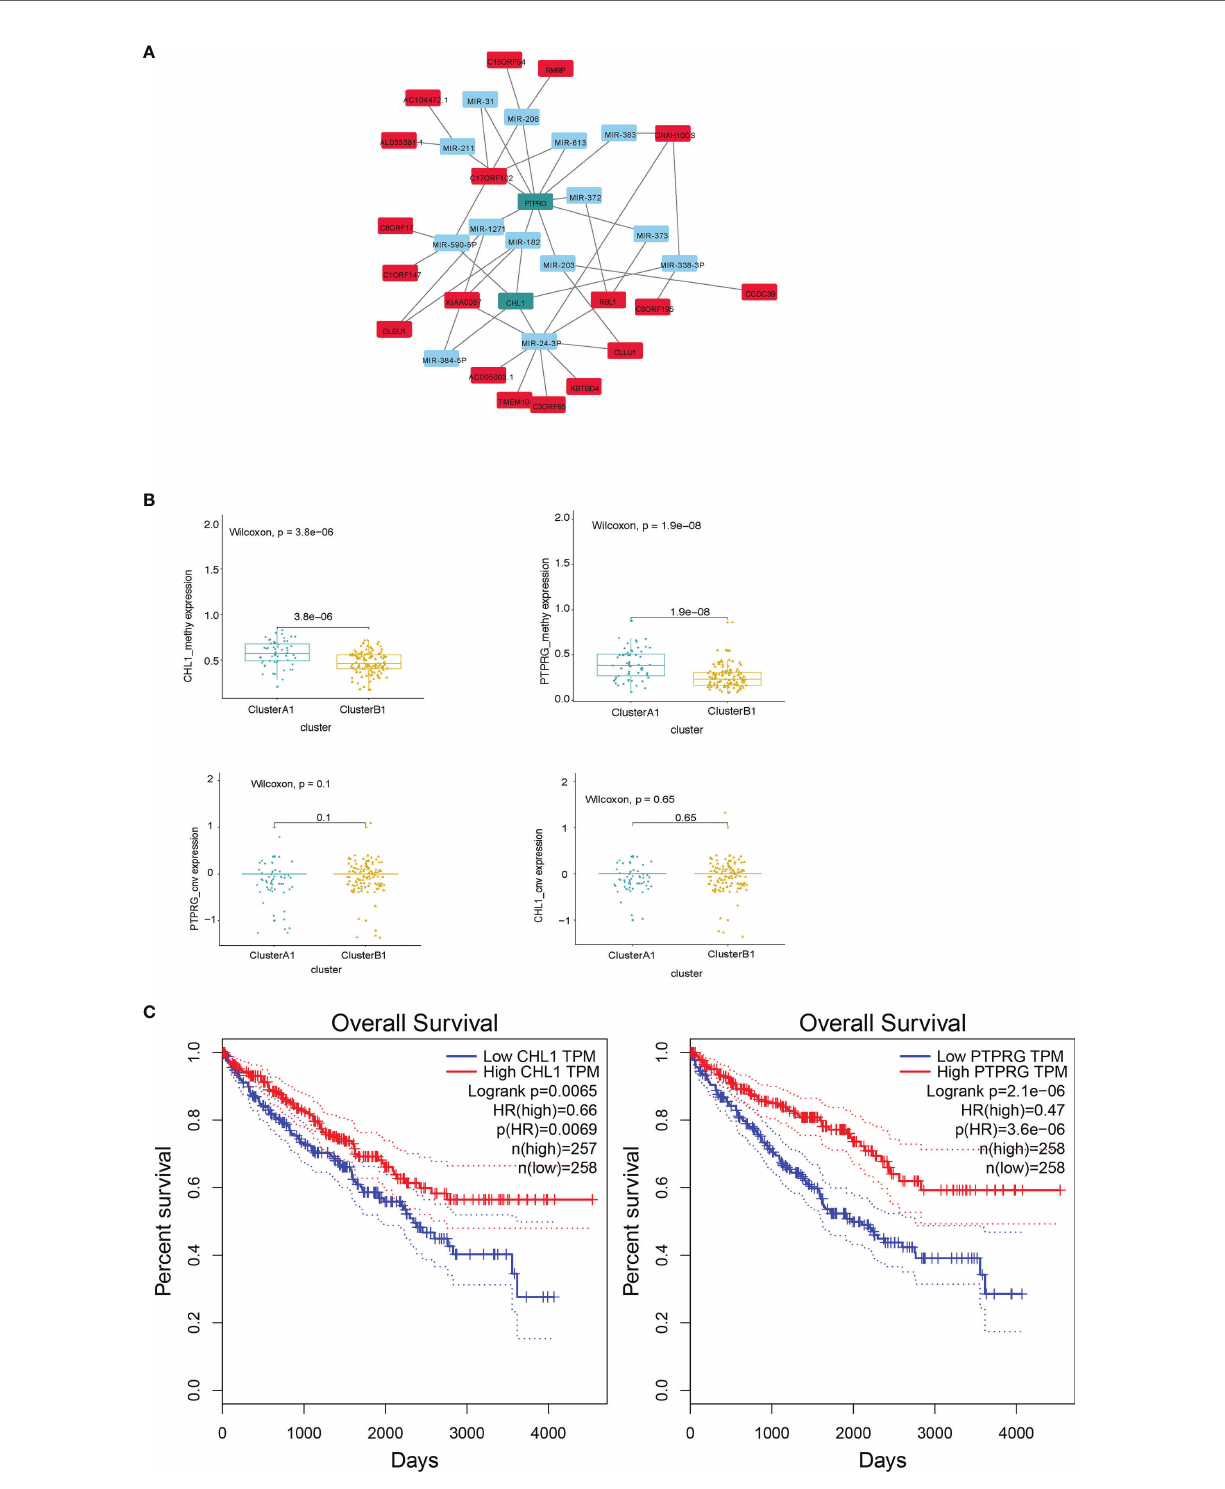
FIGURE 11 | (A) DEG hub genes diagram. (B) Methylation and copy number variations differences of PTPRG and CHL1 between clusters A1 and B1. (C) Survival curves using univariate Kaplan – Meier estimates based on expression levels of CHL1 and PTPRG in TCGA-KIRC cohorts with the online tool